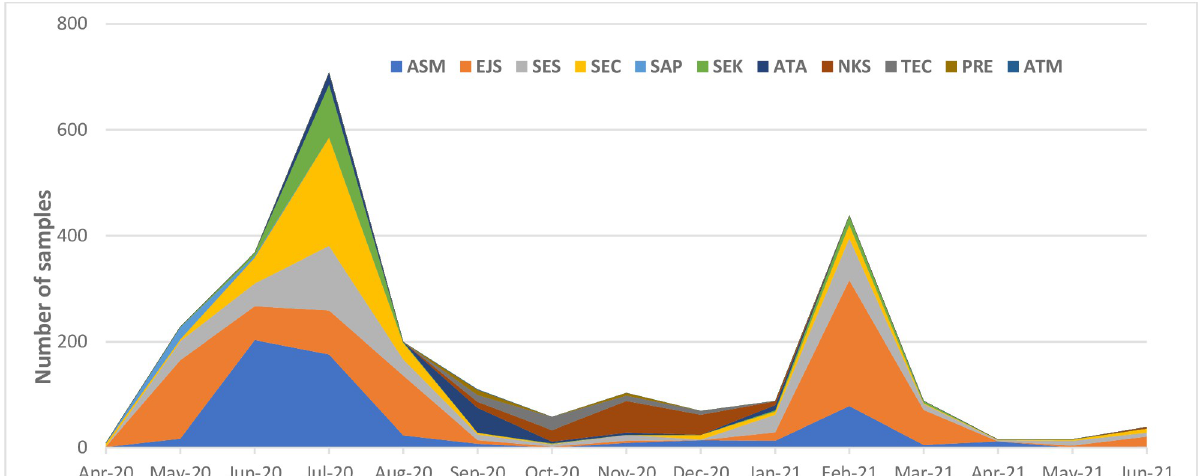
Fig 3. Distribution of samples received via zipline per district (ASM-Asante Mampong; EJS-Ejura Sekyere Odumase; SES-Sekyere South; SEC-Sekyere Central; SAP- Sekyere Afram Plains; SEK-Sekyere Kumawu; ATA-Atebubu Amantin; TEC-Techiman; NKS-Nkoranza South; PRE- Pru